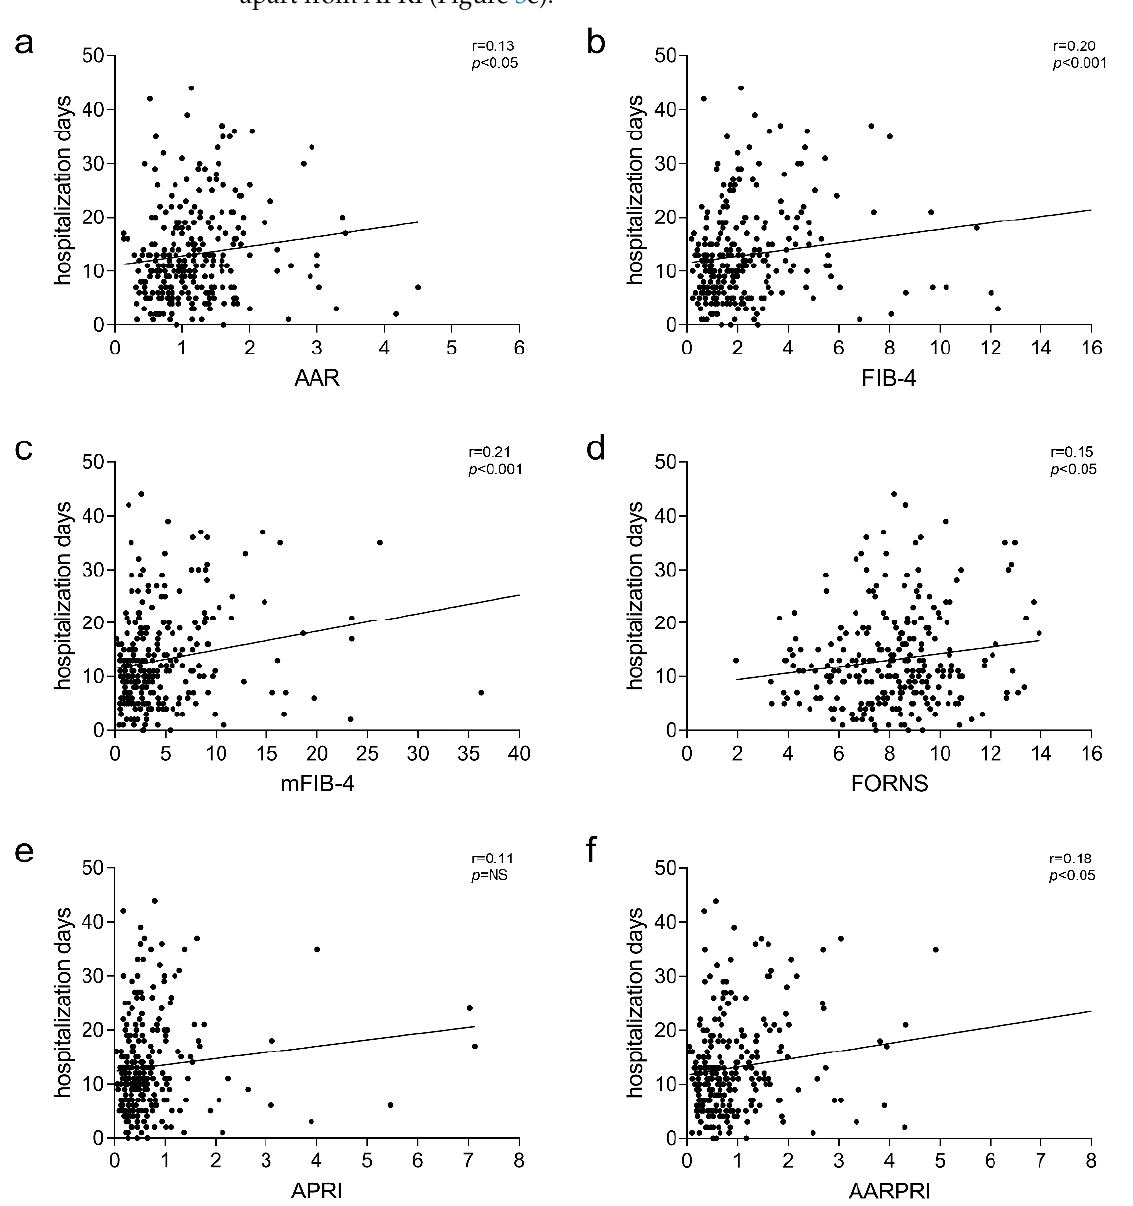
Figure 3. Correlation analysis of AAR ( a ), FIB-4 ( b ), mFIB-4 ( c ), FORNS ( d ), APRI ( e ), AARPRI ( f ) with hospitalization days in the whole population. The correlation was analysed and estimated using Pearson’s Correlation Coefficient (r). ( p ) indicates statistical significance. Each black dot represents a single patient. Abbreviations: AST to ALT ratio, AAR; fibrosis 4 index, FIB-4; modified FIB-4, mFIB-4; AAR to Platelet ratio, AARPRI.